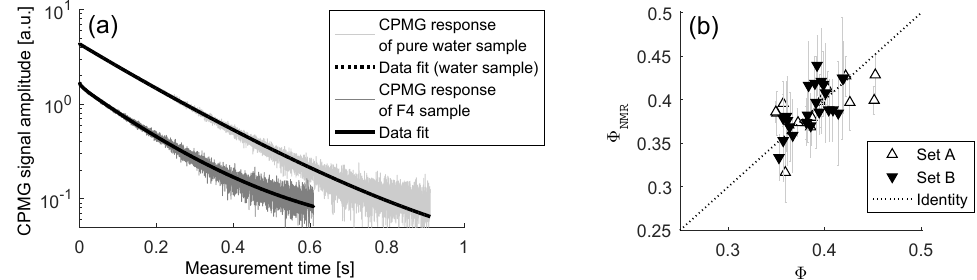
Figure 4. (a) T 2 measurement of sample F4 compared to pure water; (b) NMR-based porosity measurements compared to gravimetrical porosity for all samples.